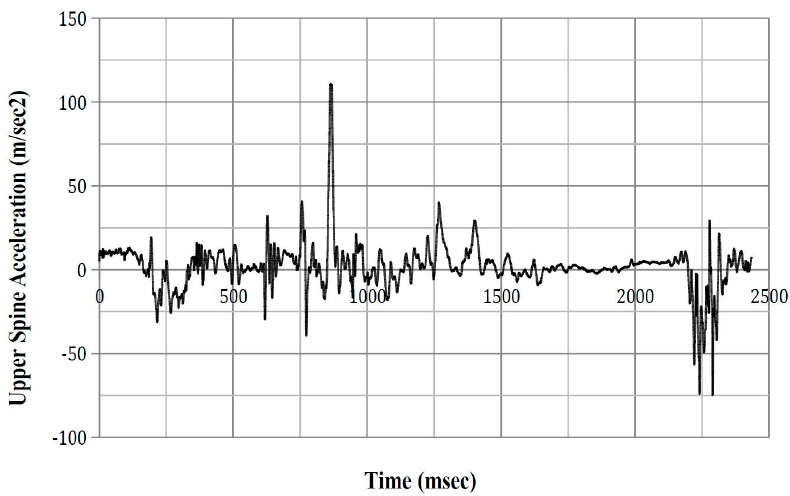
Figure A17. ATD Position 8 lower spine acceleration.